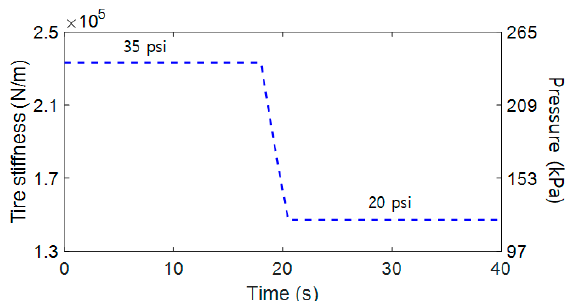
Figure 6. Tire pressure (i.e., stiffness) profile scenario for sudden pressure drop (241.3 kPa → 137.9 kPa).